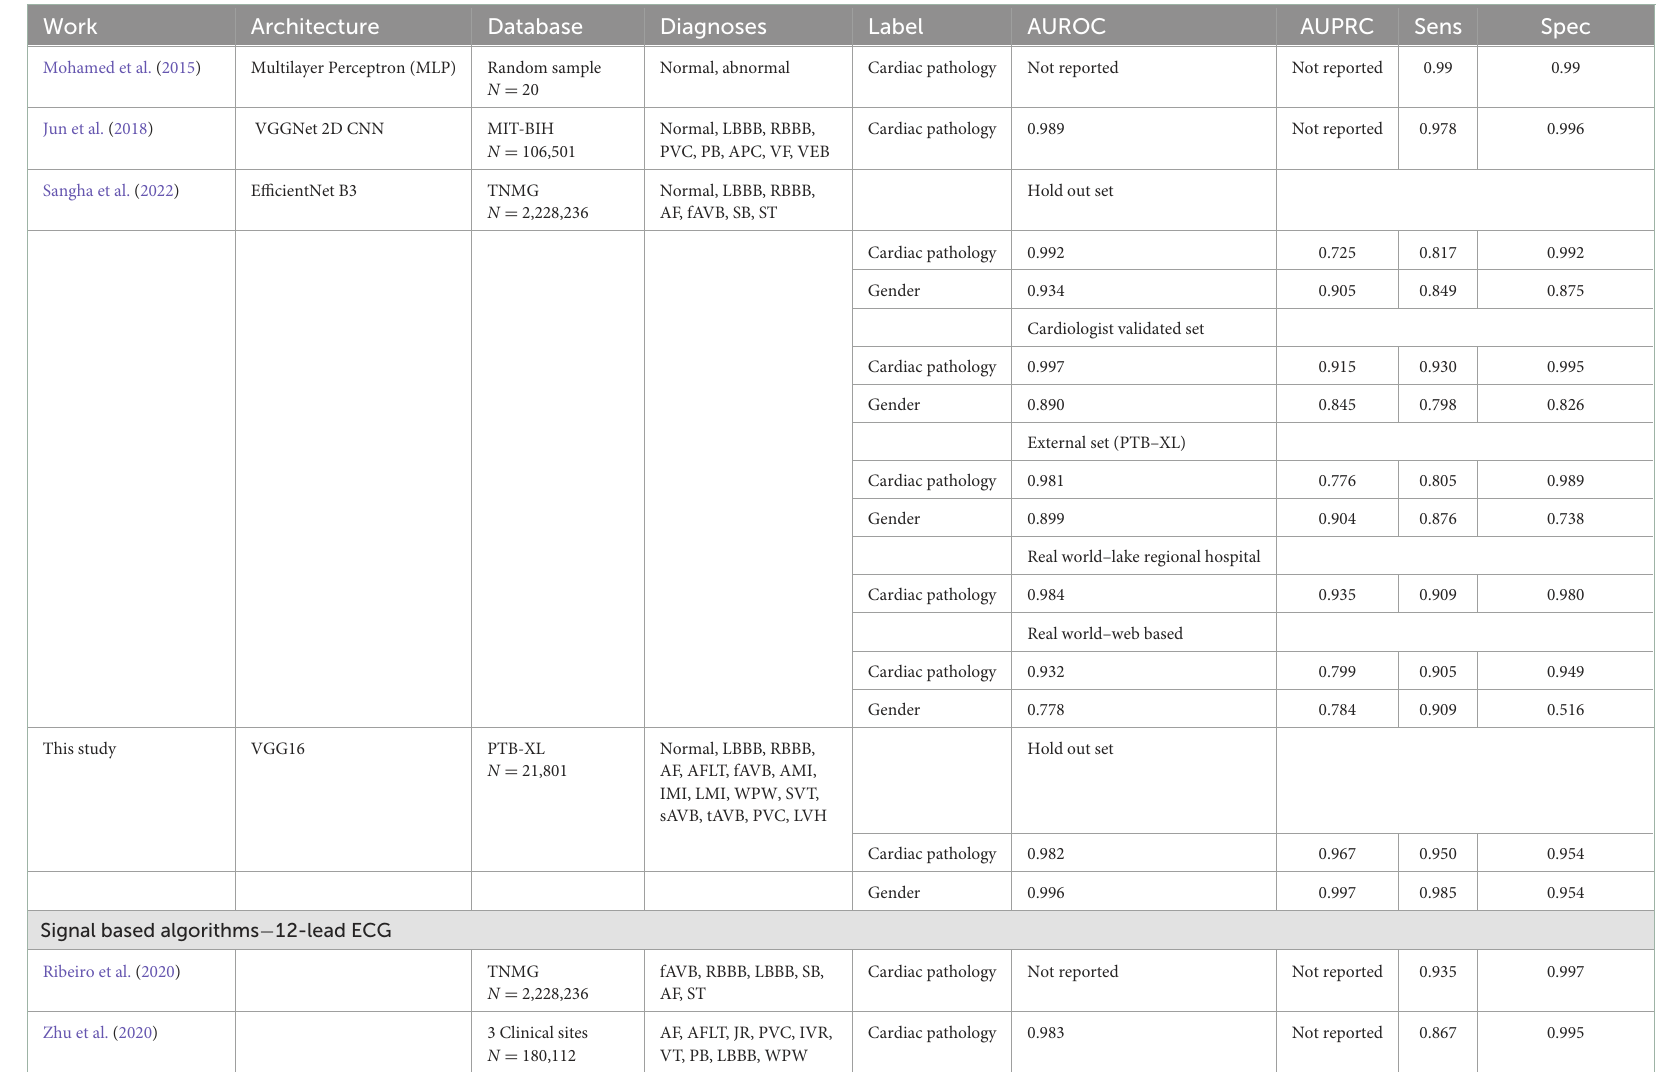
TABLE 3 Comparison of image and signal based ECG recognition